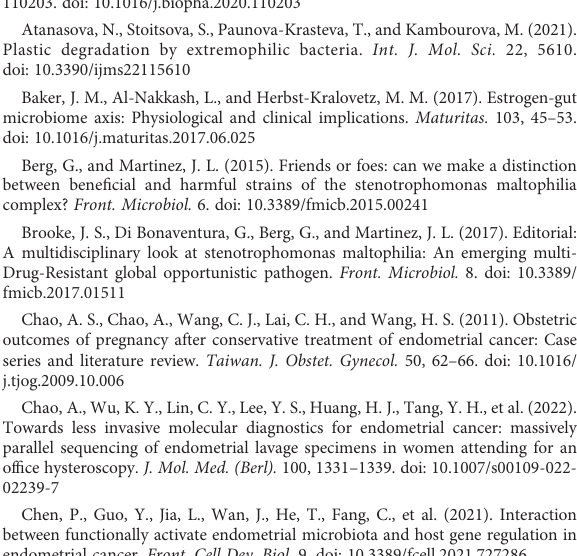
Endometrial lavage samples analyzed in this